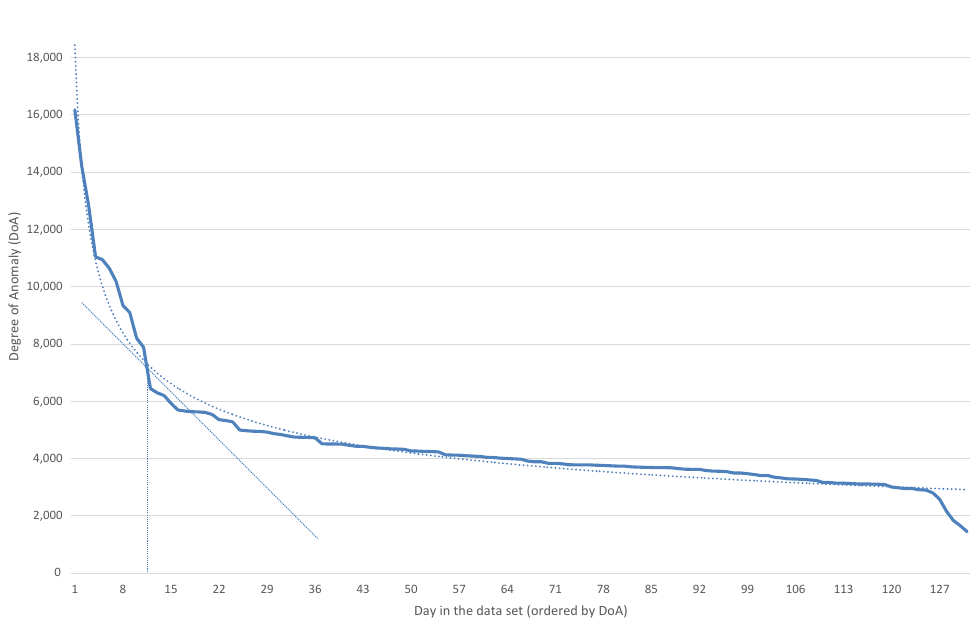
Figure 4. Days in the data set ordered according to the degree of anomaly of the difference